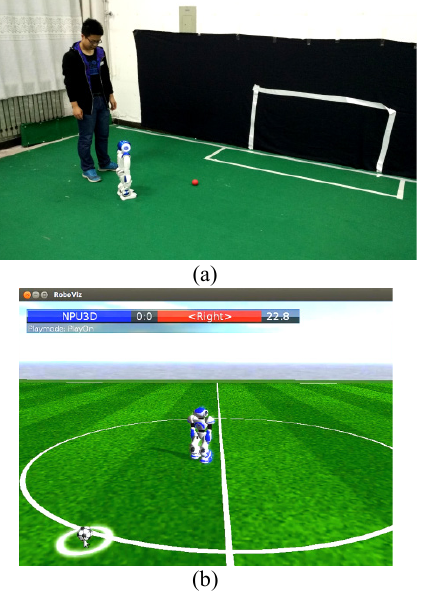
Fig. 10. Experimental system. (a) Real environment. (b) RoboCup3D simulation platform.